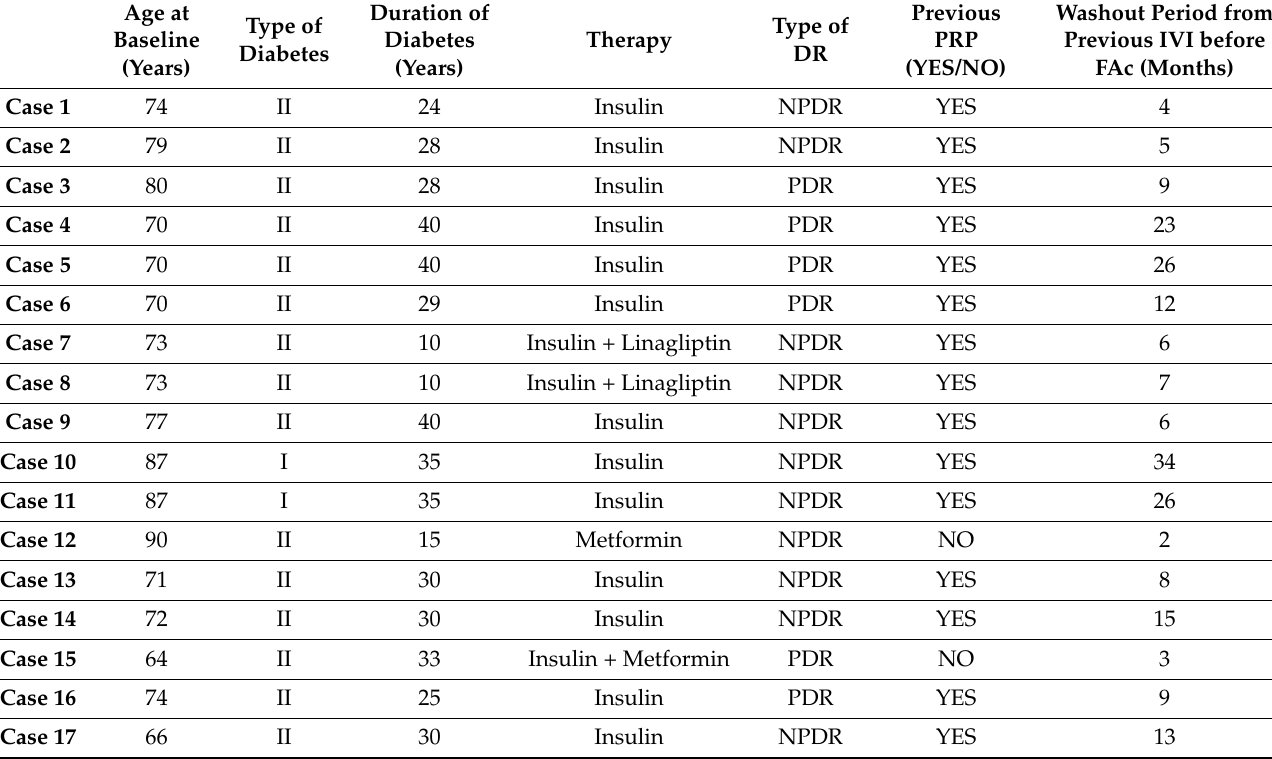
Table 1. Demographic and clinical